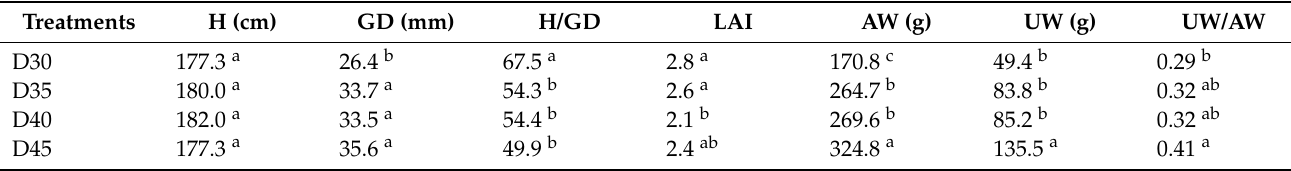
Table 5. The main growing parameters during the flowering stage among treatments in the 2018 growing season. H, GD, LAI, AW, and UW are abbreviations for height, ground diameter, leaf area index, aboveground dry matter weight, and underground dry matter weight for an individual plant,